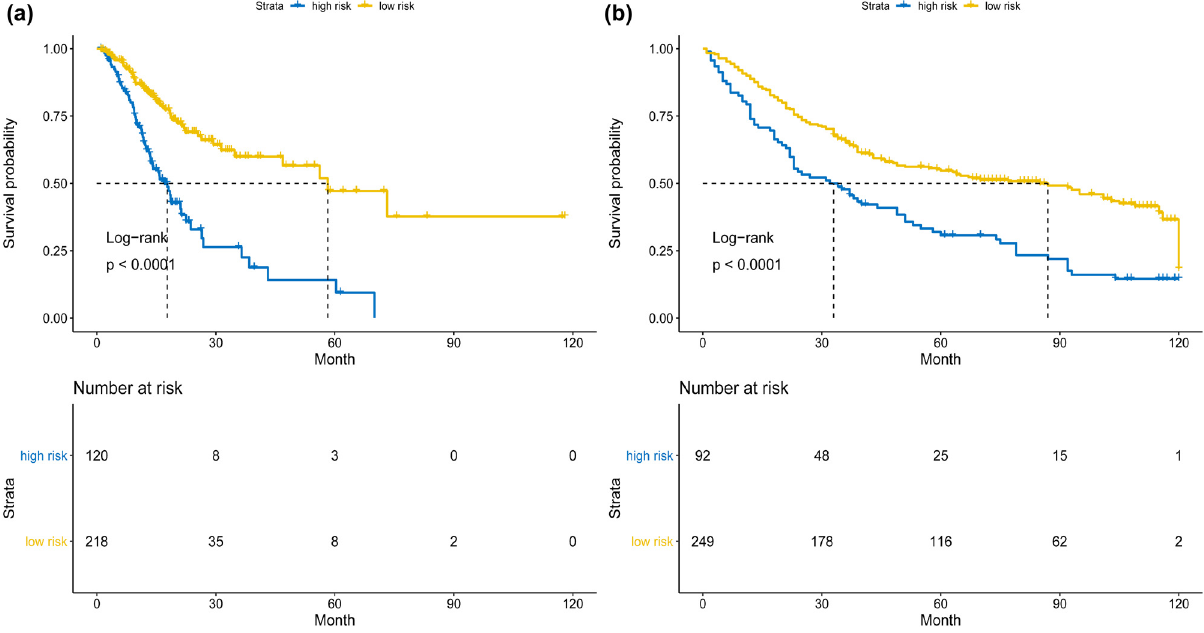
Figure 2: Kaplan – Meier curves of OS strati fi ed by the nine immune - relevant genes ’ signature score in high - and low risk for patients. ( a ) TCGA cohort and ( b ) GSE84437